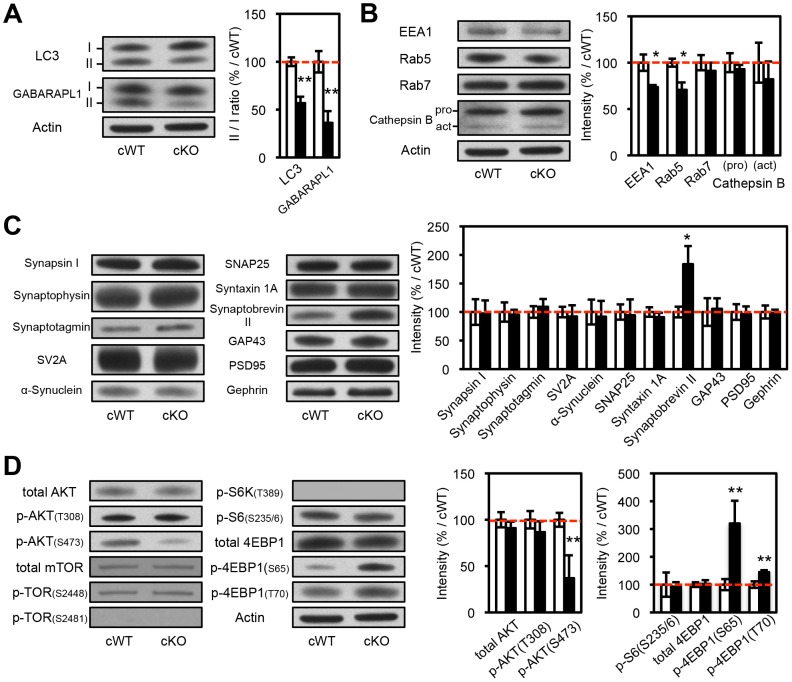
Biochemical analyses of the protein extracts from the striatal synaptosomes of Atg7 cKO mice.(A) Evidence for reduced macroautophagy activity in axon terminals of Atg7 cKO mice. Conversions of LC3-I and GABARAPL1-I into modified lipidated forms associated with autophagosome formation – termed LC3-II and GABARAPL1-II, respectively – were significantly decreased in striatal synaptosomal preparations from Atg7 cKO mice (relative to cWT mice); the incomplete reduction likely reflects the presence of non-dopaminergic axon terminals. White, Atg7 cWT; Black, Atg7 cKO. n = 5 per group. **, p<0.01. (B) Moderately reduced accumulation of early endosome markers in striatal synaptosomal preparations from Atg7 cKO mice. Both EEA1 and Rab5 are significantly decreased in striatal synaptosomal preparations from Atg7 cKO mice (relative to cWT mice), whereas late endosomal and lysosomal markers, Rab7 and Cathepsin B, unchanged. pro, procathepsin B; act, active mature Cathepsin B. Internal control Actin is same as Figure 3A. White, Atg7 cWT; Black, Atg7 cKO. n = 5 per group. *, p<0.05. (C) Selectively increased accumulation of Synaptobrevin II in striatal synaptosomal preparations from Atg7 cKO mice. Other synaptic markers were not significantly altered. Internal control Actin is same as Figure 3A. White, Atg7 cWT; Black, Atg7 cKO. n = 5 per group. *, p<0.05. (D) Non-canonical alterations of PI3K/mTOR pathway signaling in synaptosomal preparations from Atg7 cKO mice. Phosphorylation of AKT at Ser 473 (S473) was decreased in Atg7 cKO mice, whereas phosphorylation at Thr 308 (T308) unchanged. Phosphorylations of mTOR at Ser 2448 (S2448) or Ser 2481 (S2481) were unchanged in Atg7 cKO mice. Phosphorylations of 4EBP1 at Ser 65 (S65) and Thr 70 (T70) were increased in the striatal synaptosomes of Atg7 cKO mice, whereas phosphorylations of S6 (T389) and S6K (S235/236) were unchanged. Internal control Actin is same as Figure 3A. n = 5 per group. **, p<0.01.